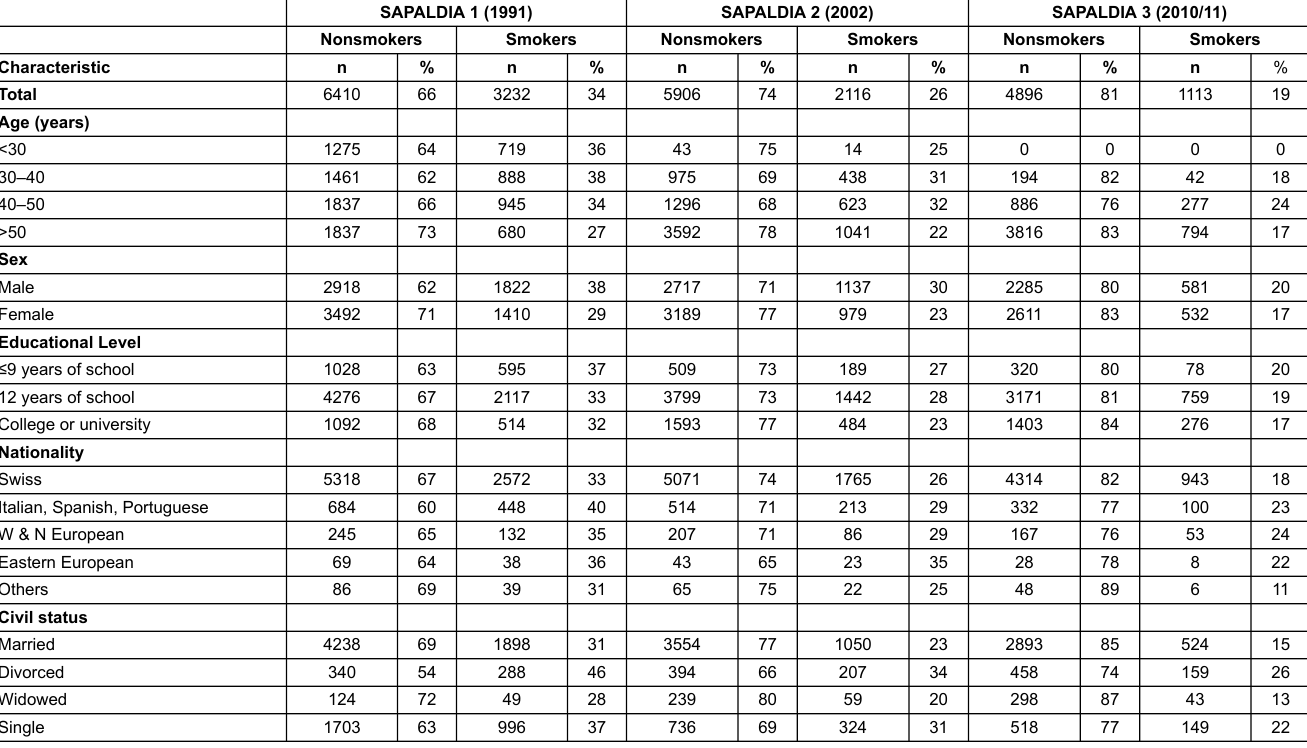
Table 1: Characteristics of the cohort at the three surveys of SAPALDIA in 1991, 2002 and 2010/11 by smoking